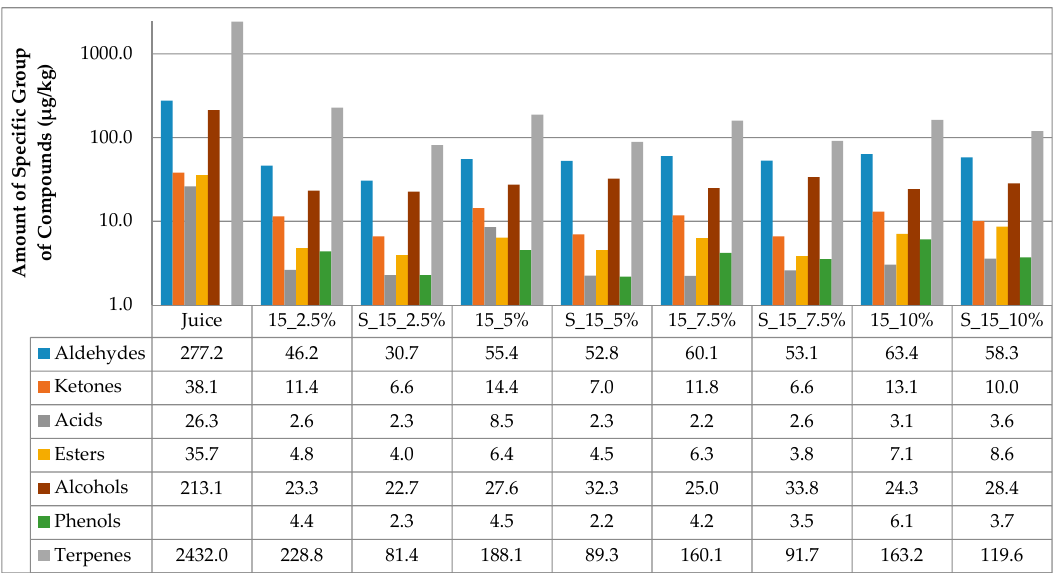
Figure 1. Amount of volatiles of specific chemical group in juice and on cellulose/raspberry complexes after 15 min of complexation and after storage (2.5%, 5%, 7.5% and 10%—amounts of used cellulose; 15—time of complexation; S—storage).